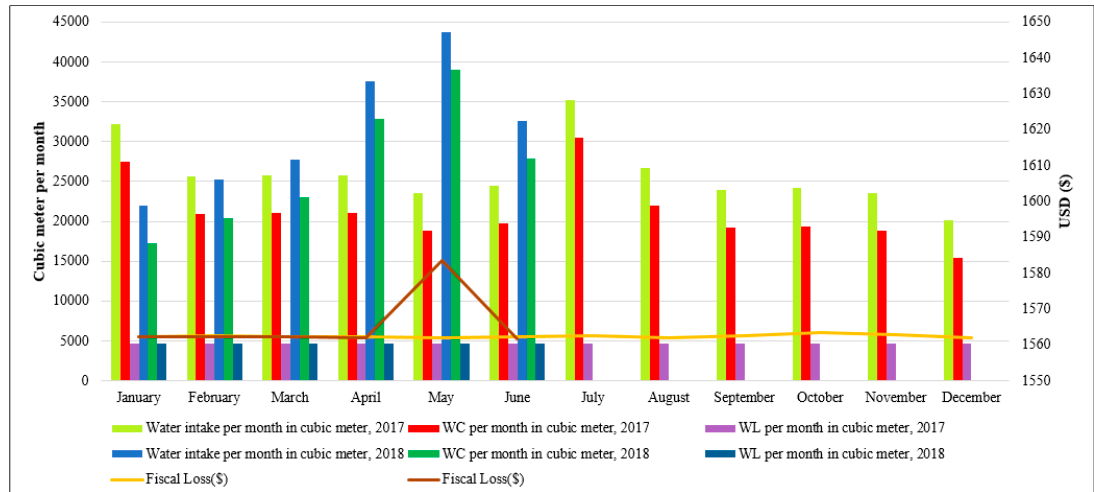
Figure 2. Details of water intake, water consumption, water loss (per month in m 3 of 2017 and 2018, respectively), and their fiscal loss in $.